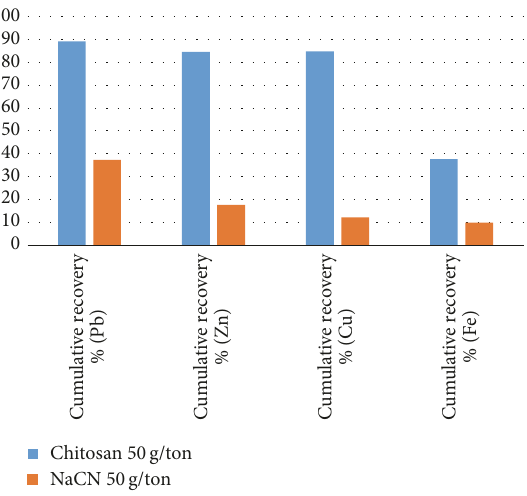
Figure 10: Zinc recovery and concentrate grade as a function of chitosan dosage in comparison with NaCN depressant.